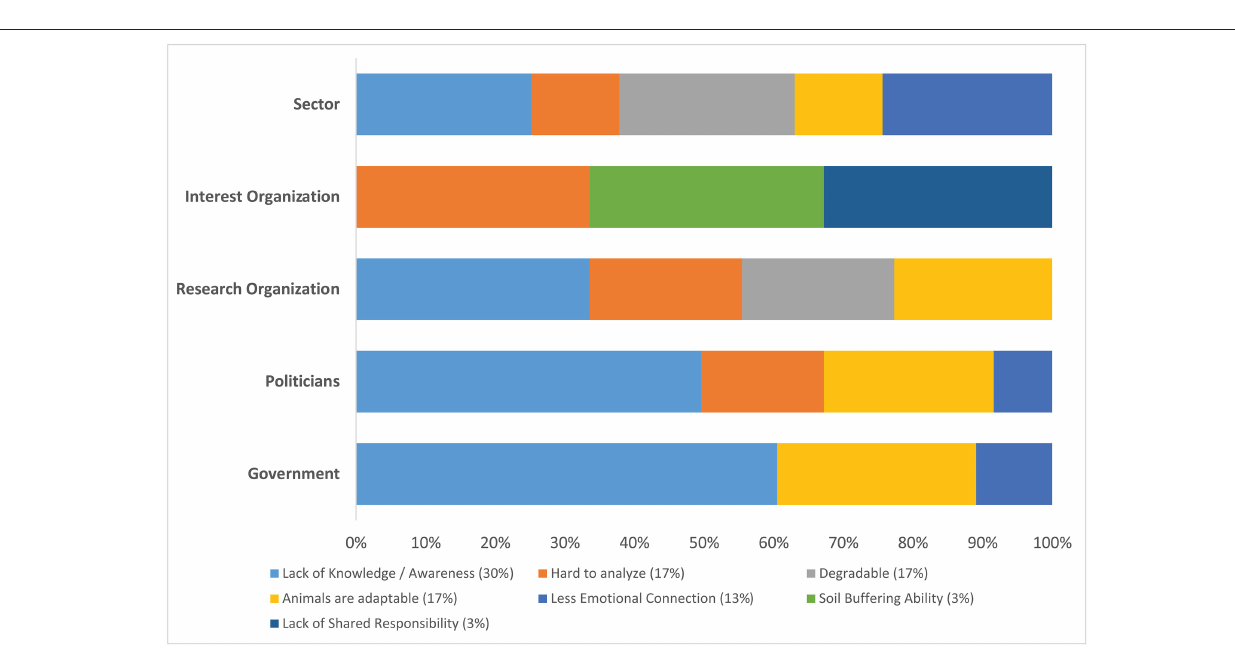
the lack of standardized methods to detect MPs, noting that MPs analysis in general is not easy and it is harder to do so in